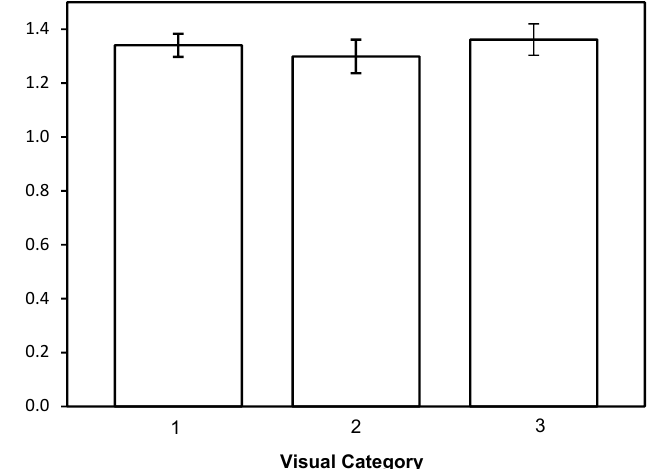
Figure 7. Mean transverse stress wave velocities (km/s) by visual category. Error bars represent a 95% confidence interval.